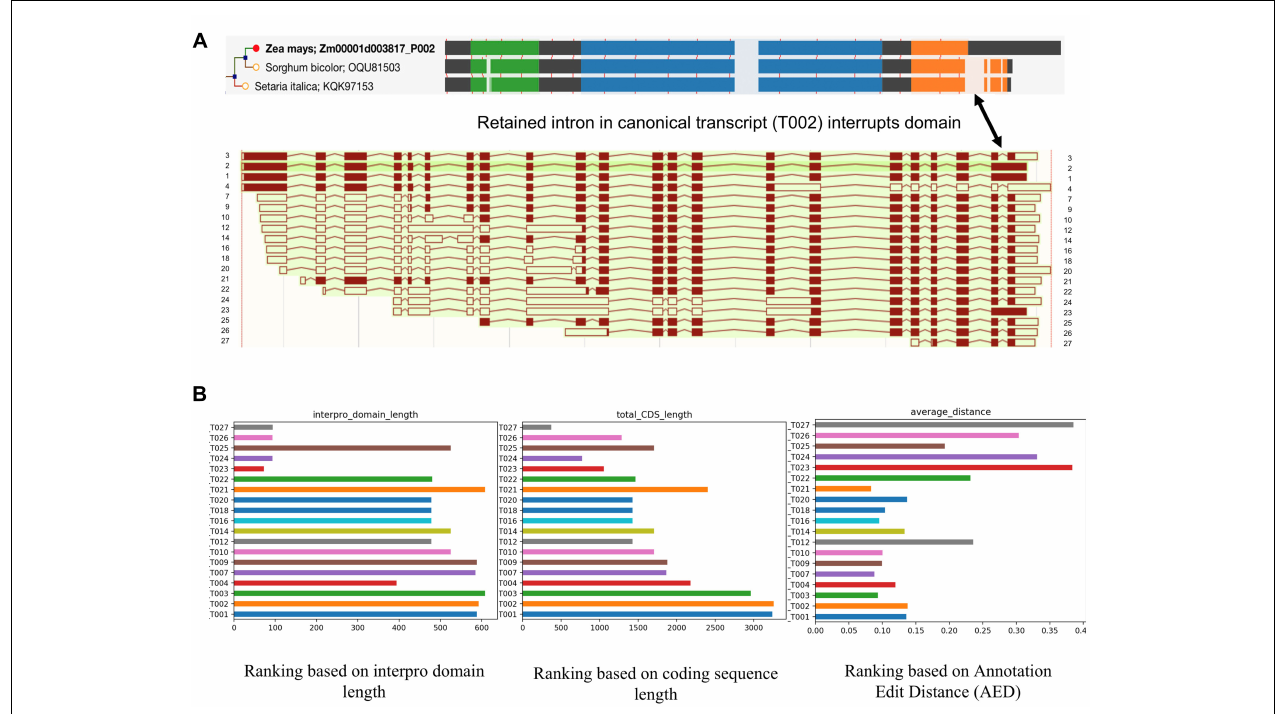
FIGURE 3 | Alignment and ranking of different isoforms. (A) Gene tree multiple sequence alignment color coded by interpro domain. The orange domain is conserved in grass orthologs, but is not identified completely in maize because a retained intron disrupts it and induces a frame shift (shown by arrow). The resulting longer translation was selected for analysis in the gene tree pipeline. Different colors mean different interpro domains, black color means “no domain here,” lightly shaded area indicates a gap in the multiple sequence alignment. The thin red lines show the positions of exon junctions. (B) Ranking of different isoforms of Zm00001d003817 based on different standards. T002 has the longest CDS, but T003 outperforms it in domain length and annotation edit